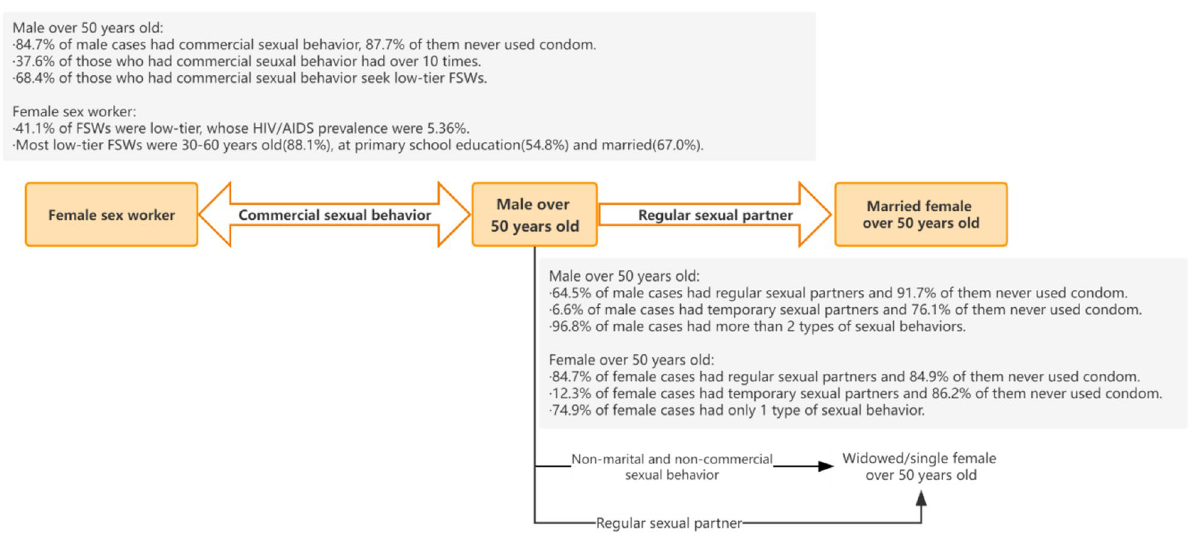
Figure 5. A mode of transmission based on data from multiple